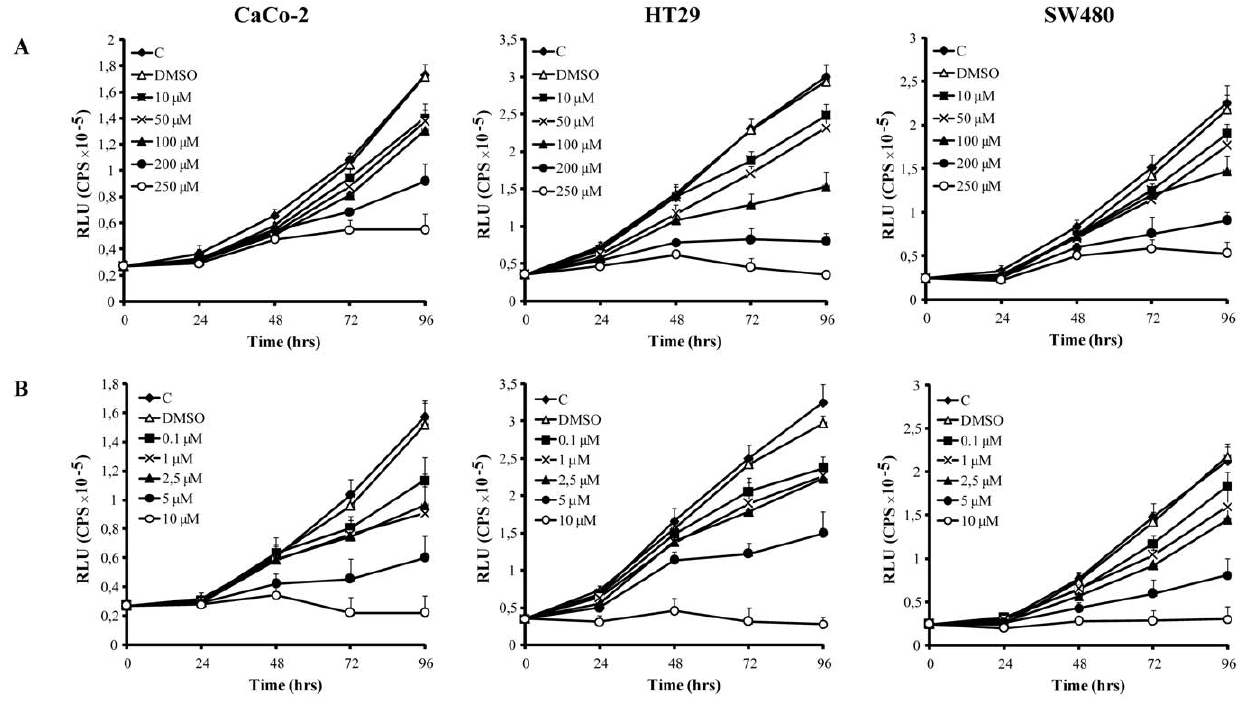
Figure 1. Cell proliferation. A. Effect of different doses of rosiglitazone (10, 50, 100, 200, 250 m M) on CaCo-2, HT29 and SW480 cell proliferation; B. effect of different doses of AS601245 (0.1, 1, 2.5, 5, 10 m M) on CaCo-2, HT29 and SW480 cell proliferation. Values are detected by measuring the luminescence released by the metabolically active cells. The values, expressed in RLUs are the means S.D. of three separate experiments.